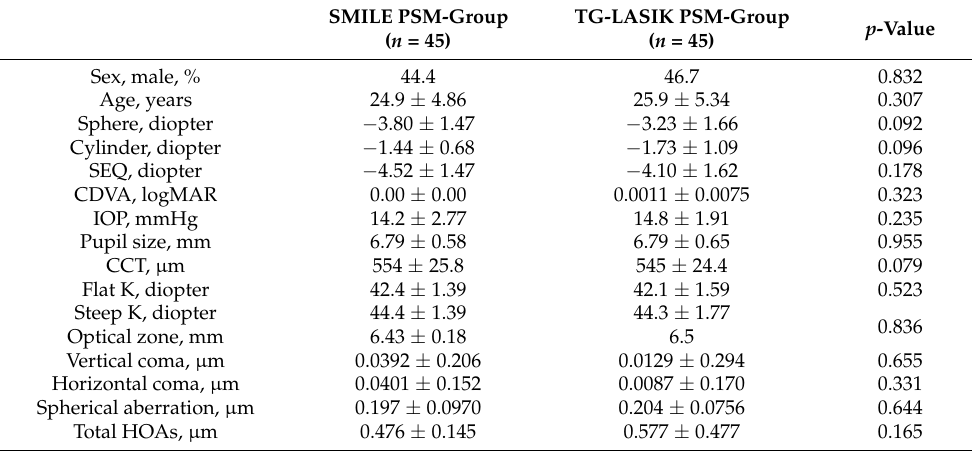
Table 1. Preoperative characteristics of the two groups after propensity score matching.